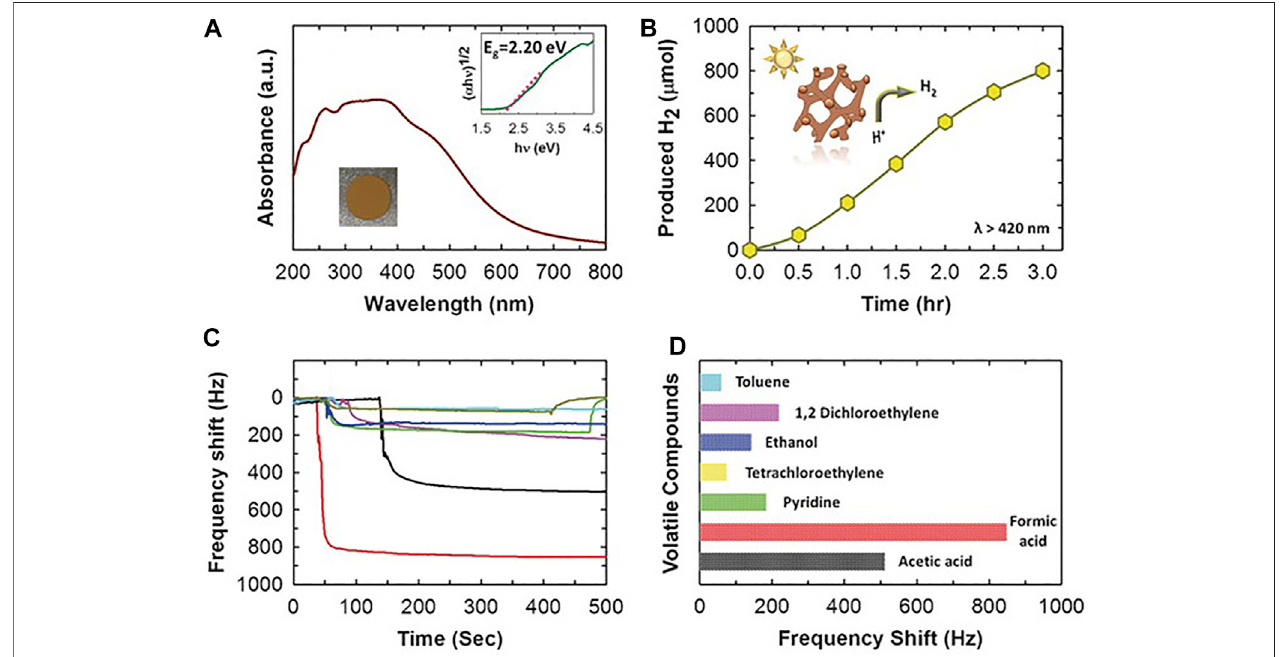
FIGURE 1 | (A) UV/Vis absorption spectrum of MCN-8 (inset: corresponding Tauc plot and photograph of MCN-8). (B) Time course of H2 evolution for MCN-8 in visible light ( λ > 420 nm). (C) Response of MCN-8 coated QCM sensor on different organic vapors, a) toluene (sky-blue), b) DCE (purple), c) ethanol (blue), d) tetrachloroethylene (yellow), e) pyridine (green), f) formic acid (red), and g) acetic acid (black). (D) Bar graphs depicting different frequency shifts to different vapors as detected by the QCM sensor. Reproduced with permission from (Mane et al.,